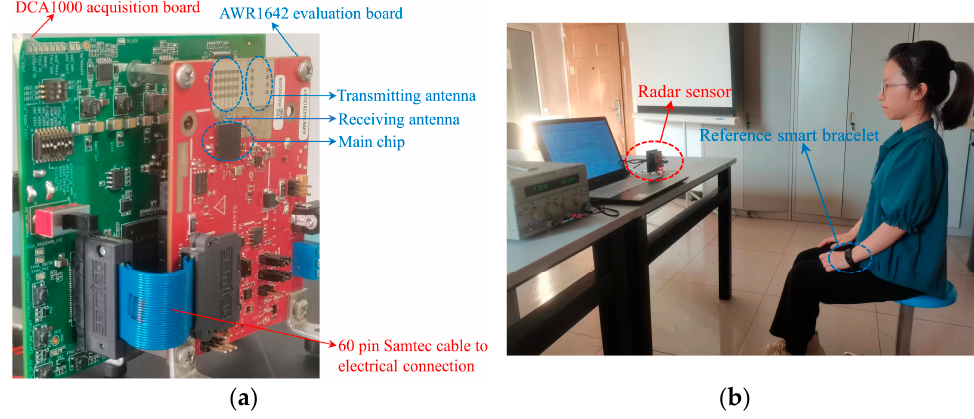
Figure 8. ( a ) TI AWR1642 sensor system; ( b ) Measurement scenario.